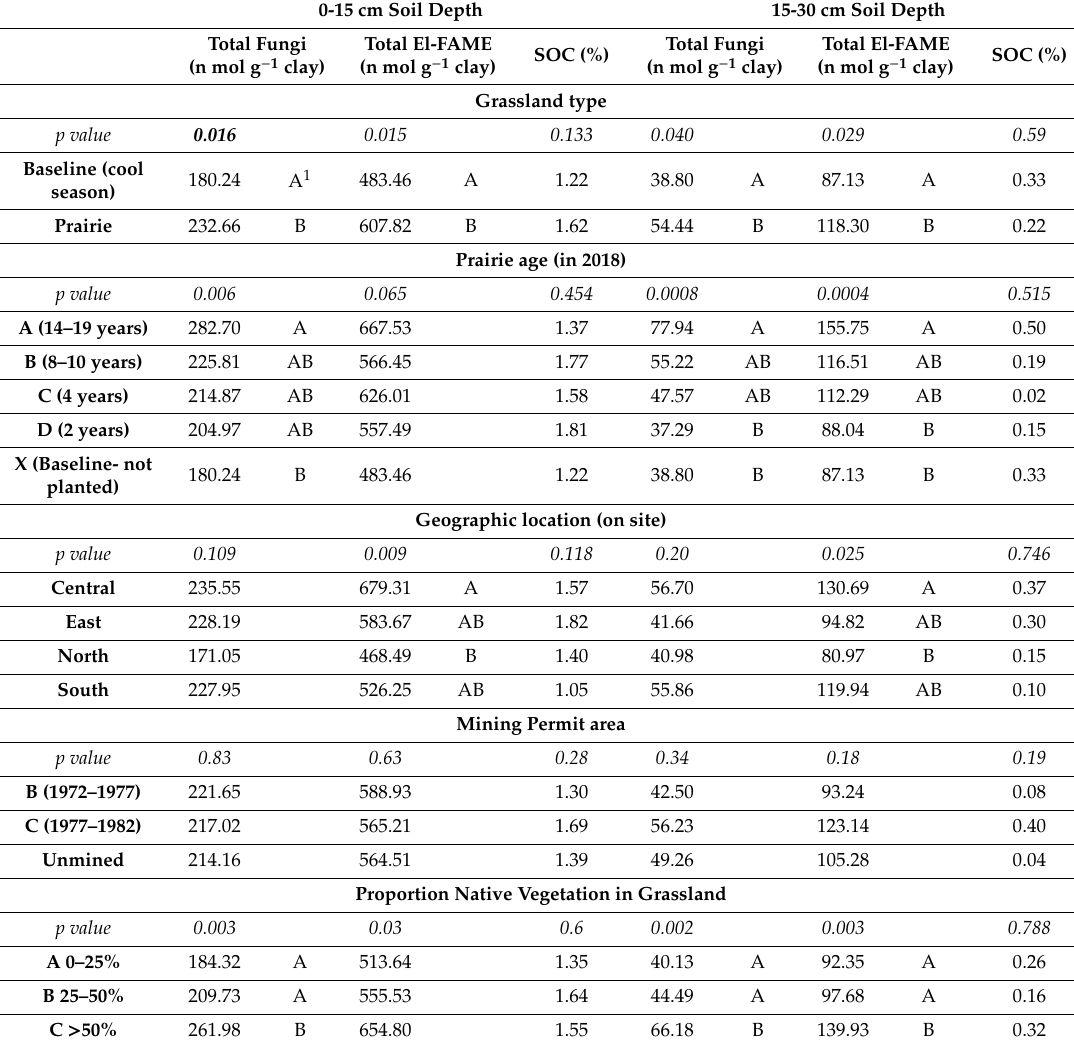
(SOC, Table 2), geogenic organic carbon (GOC), total organic carbon (TOC), and particulate organic matter (POM) were not significantly di ff erent between grassland type or prairie age (GOC, TOC, POM, groupings not shown). Table 2. Soil fungal abundance, microbial biomass in 2018, and soil organic carbon (SOC) in 2017 classified by factors in the experimental design at 0–15 cm and 15–30 cm